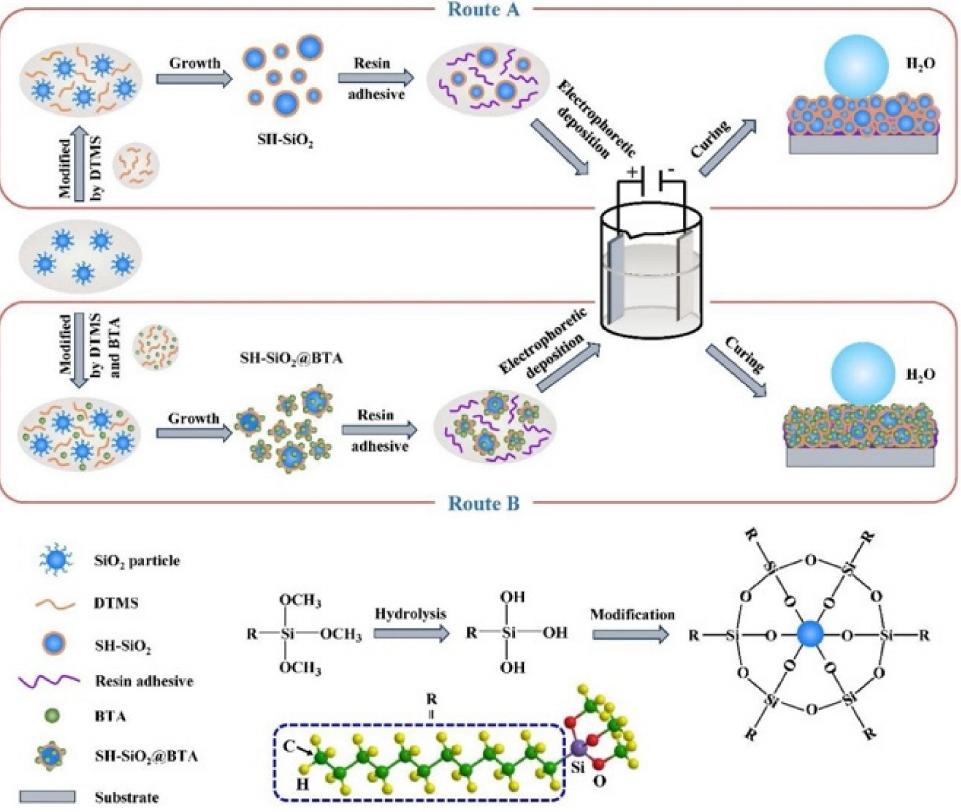
Figure 14. Schematic illustration of the EPD process for the fabrication of SH-SiO 2 (Route A) and SH- SiO 2 @BTA (Route B) nanoparticle-based SH surfaces (Reprinted from [98] with permission from